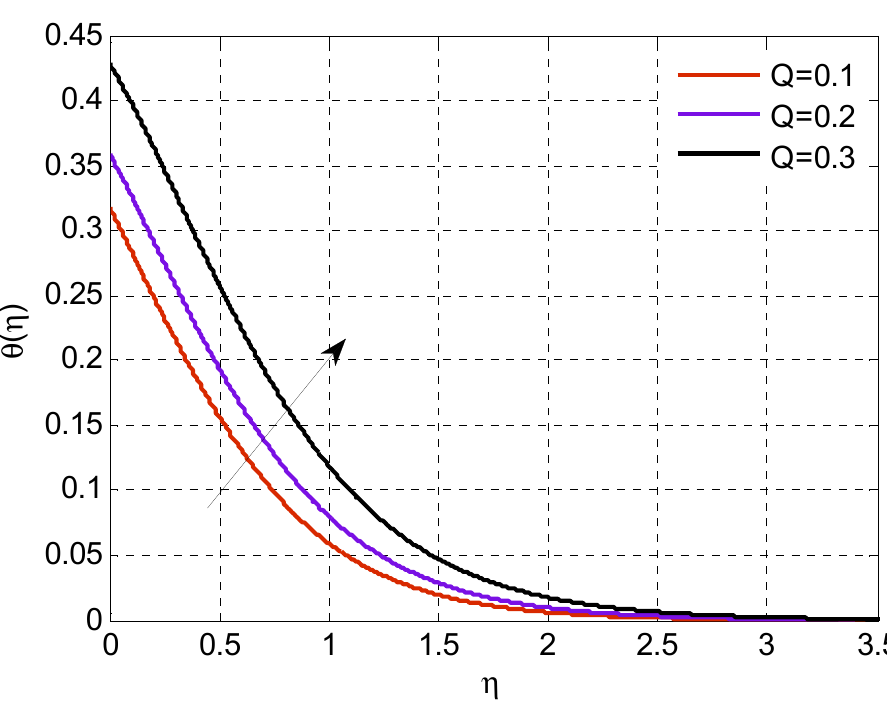
Figure 11. Effect of heat source parameter on temperature profile using G = 1, K b = 1, λ = 0.5, F r = 0.1, P r = 4, R d = 0.1, Bi = 0.5, and N = 3040.